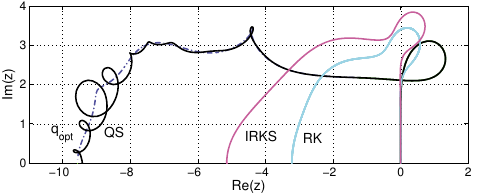
Figure 1. Stability regions of approximation of order p = 5 to exp( z ), of GLM with IRKS corresponding to η = 3 / 5, and of GLMs of order p = s − 1 = 5 with QS with residual = 7 · 10 − 7 . Stability region of optimal quadratic polynomial q opt is plotted by dashed line.